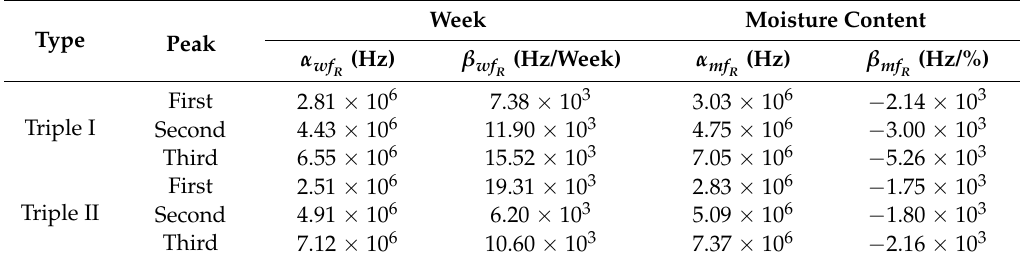
Table 4. Triple series coil αβ value for resonance frequency against the weeks and moisture